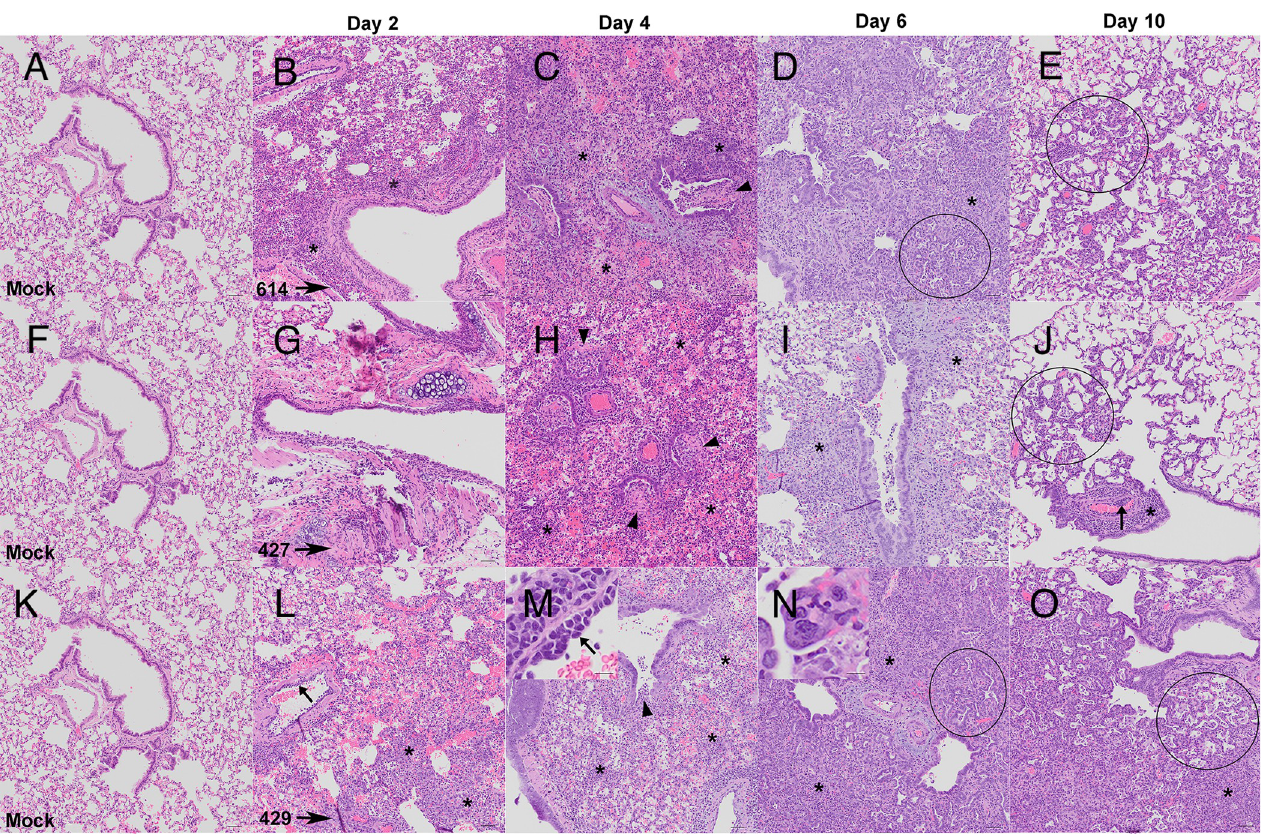
Fig 3. The nature of lung histopathology in hamsters after intranasal inoculation with B.1 (614G), B.1.427 and B.1.429 is similar. A, F, K) histology of normal lungs from uninfected hamsters. Top row: Histology of B.1 (614G) infection after B) 2 days PI, C) 4 days PI, D) 6 days PI, E) 10 days PI. Middle row: Histology of B.1.427 infection after G) 2 days PI, H) 4 days PI, I) 6 days PI, J) 10 days PI. Bottom row: Histology of B.1.429 infection after L) 2 days PI, M) 4 days PI, inset: and Perivascular cuffing with endothelium of a small vessel lifted off basal lamina by inflammatory infiltrate of lymphocytes and a few polymorphonuclear leukocytes (PMNs). N) 6 days PI, inset: multinucleate syncytial giant cell in bronchiolar epithelium. O) 10 days PI. Asterisks = mixed inflammatory infiltrate (lymphocytes, PMNs and macrophages); arrowheads = suppurative bronchiolitis with rupture of bronchiolar wall; arrows = endothelialitis; circles = foci of type II pneumocyte hyperplasia. Hematoxylin and eosin stain. Original magnification: 100x. Scale bars equal 50 um, Inset scale bars equal 20 um.